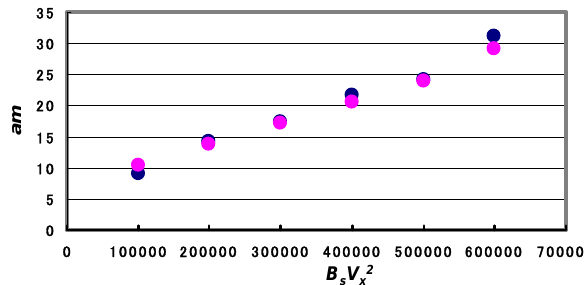
Fig. 3. Comparison of average am values for each B s V 2 x bin for equinoxes (blue circles) and those for solstices (red circles). Solar wind velocity is reduced by a factor sin (66.5) for